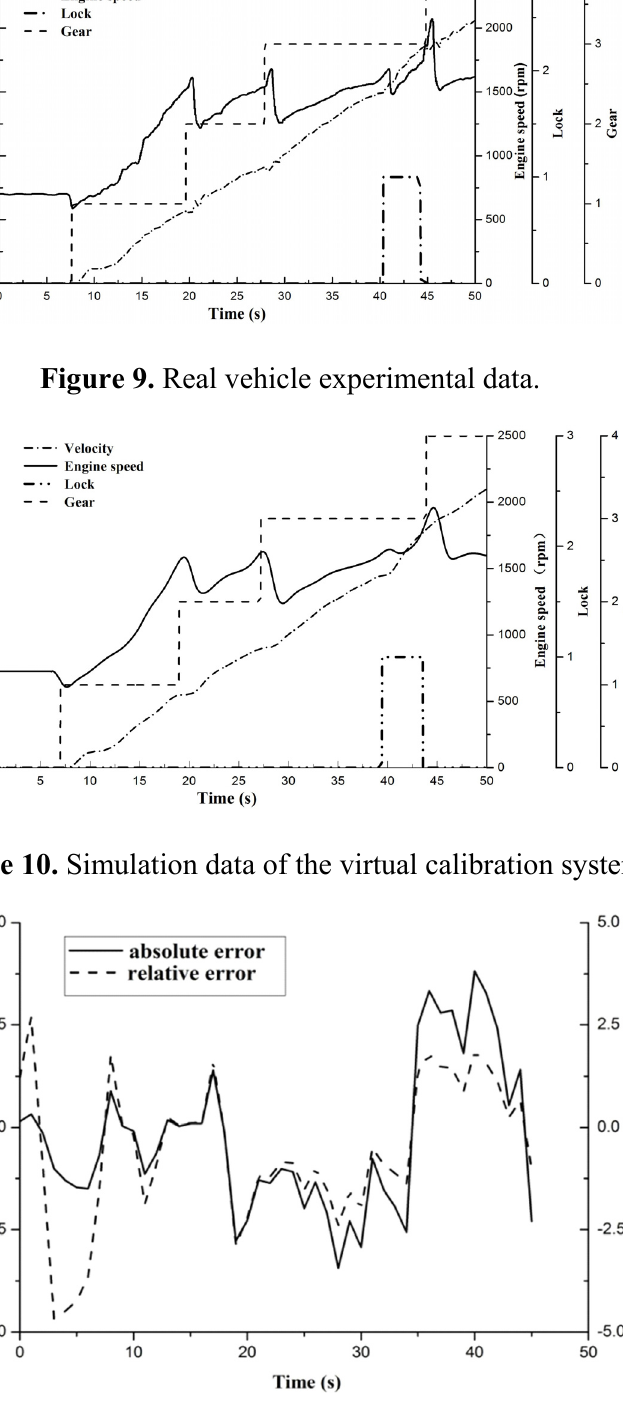
Figure 11. Error between the simulation velocity and the real